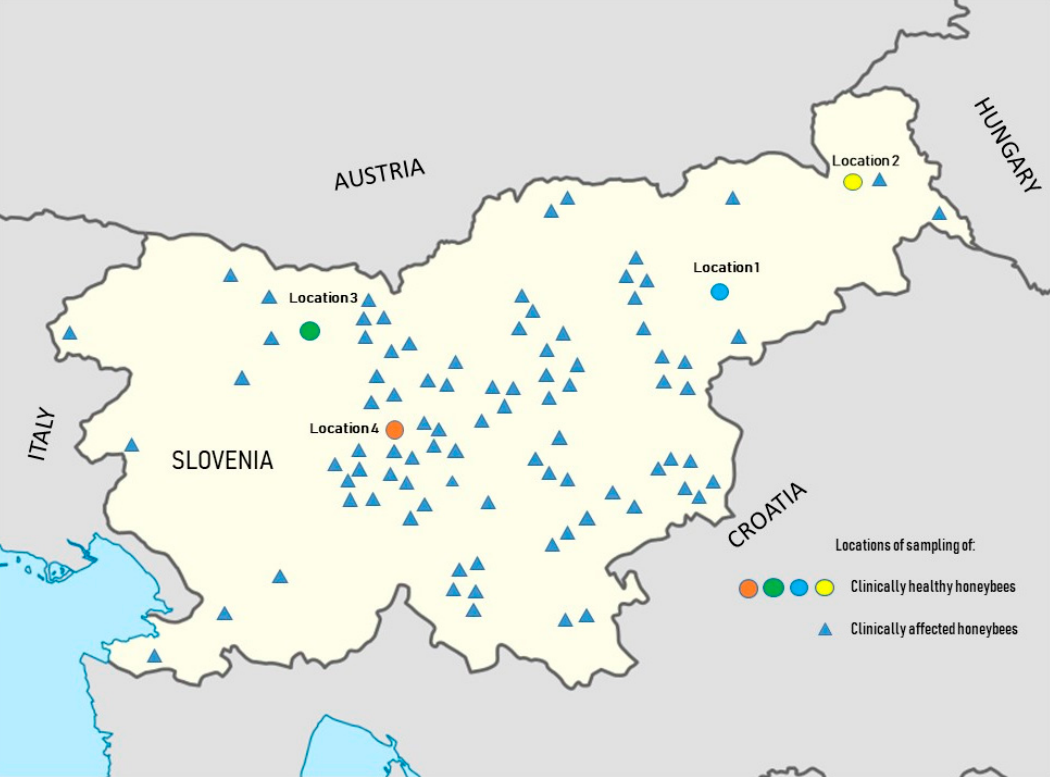
Figure 1. Locations of sample collection of healthy honeybees (Location 1—Štajerska, Location 2—Prekmurje, Location 3—Gorenjska, Location 4—Ljubljana) marked with in different colours and clinically affected honeybees marked with ▲ from throughout Slovenia.